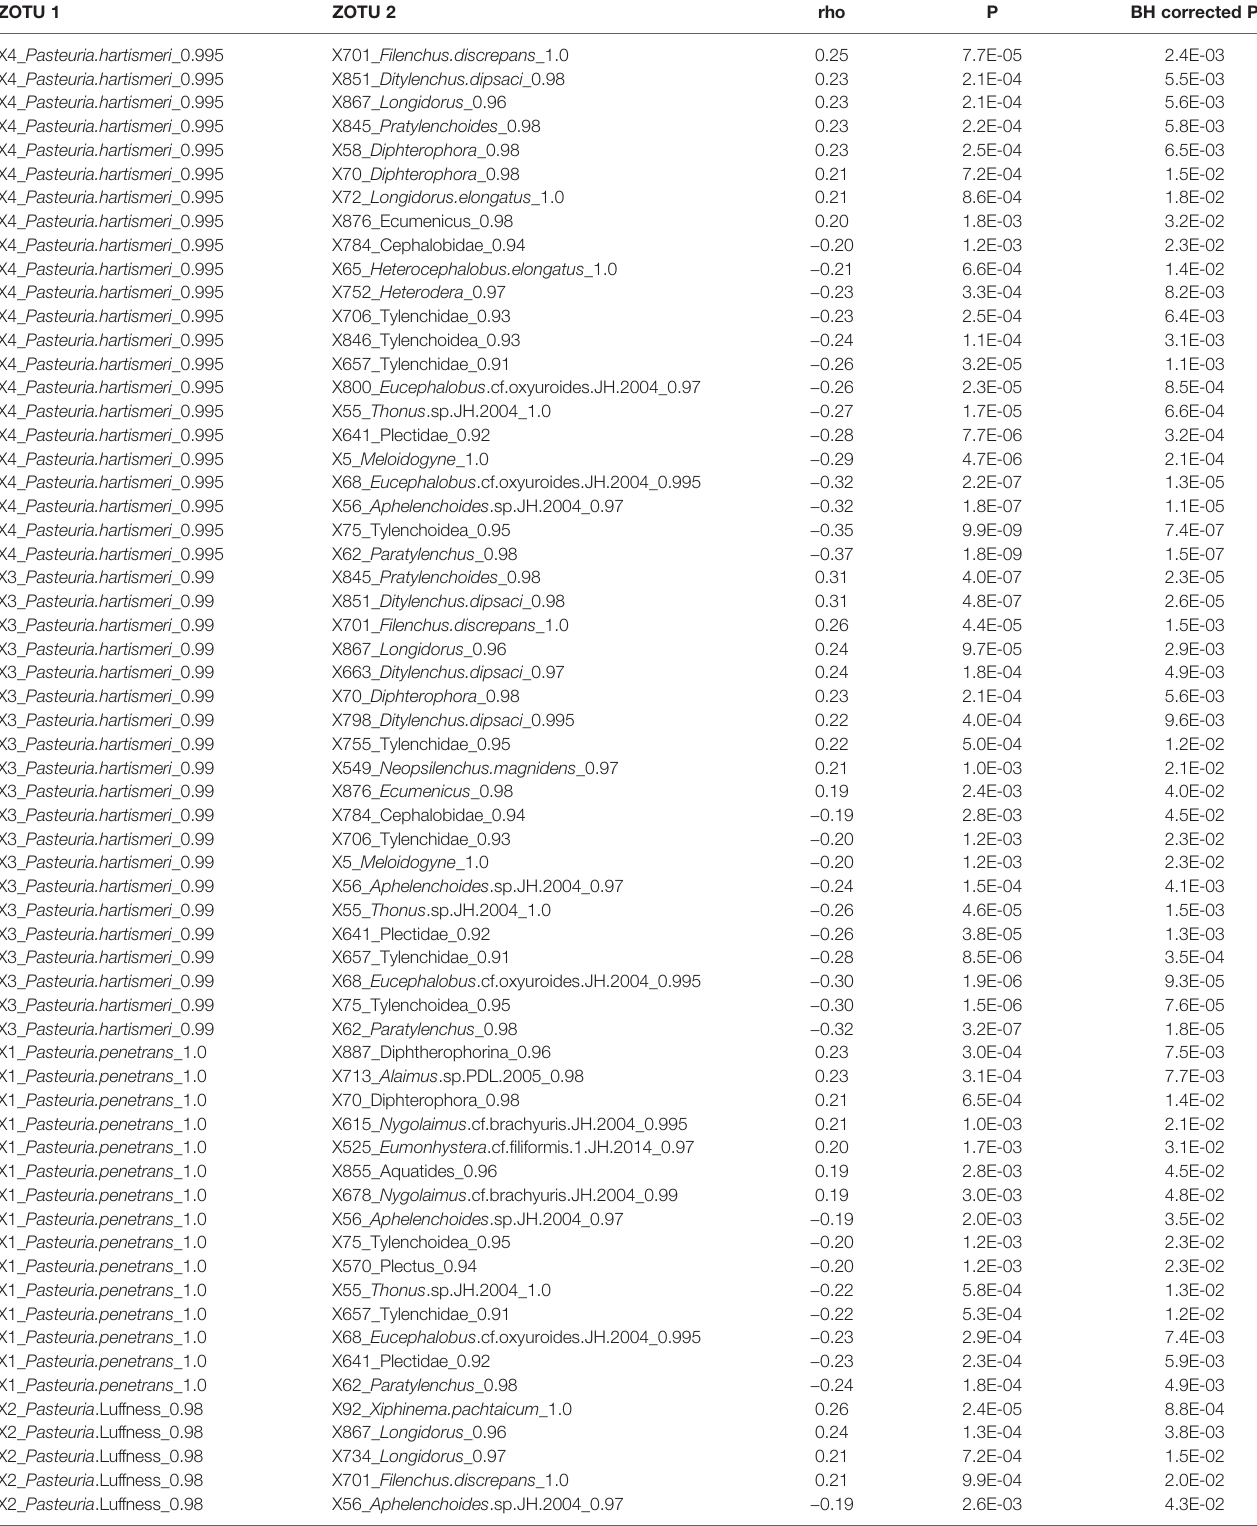
TABLE 4 | The top three most abundant Pasteuria spp. ZOTUs in the ESFN dataset and respective metazoan ZOTU Spearman ’ s rank correlations which were statistically signi fi cant after Benjamini-Hochberg correction. ZOTU